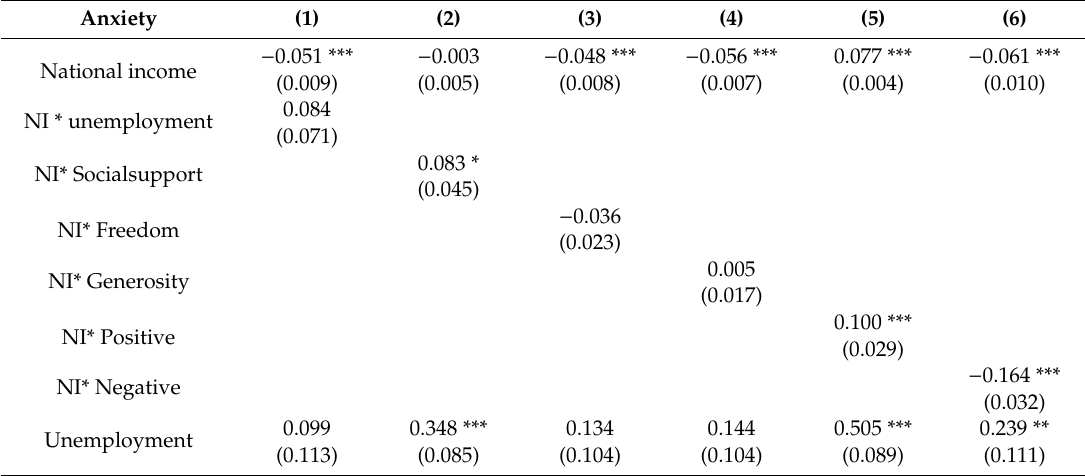
Table 10. The moderating e ff ect between national income and